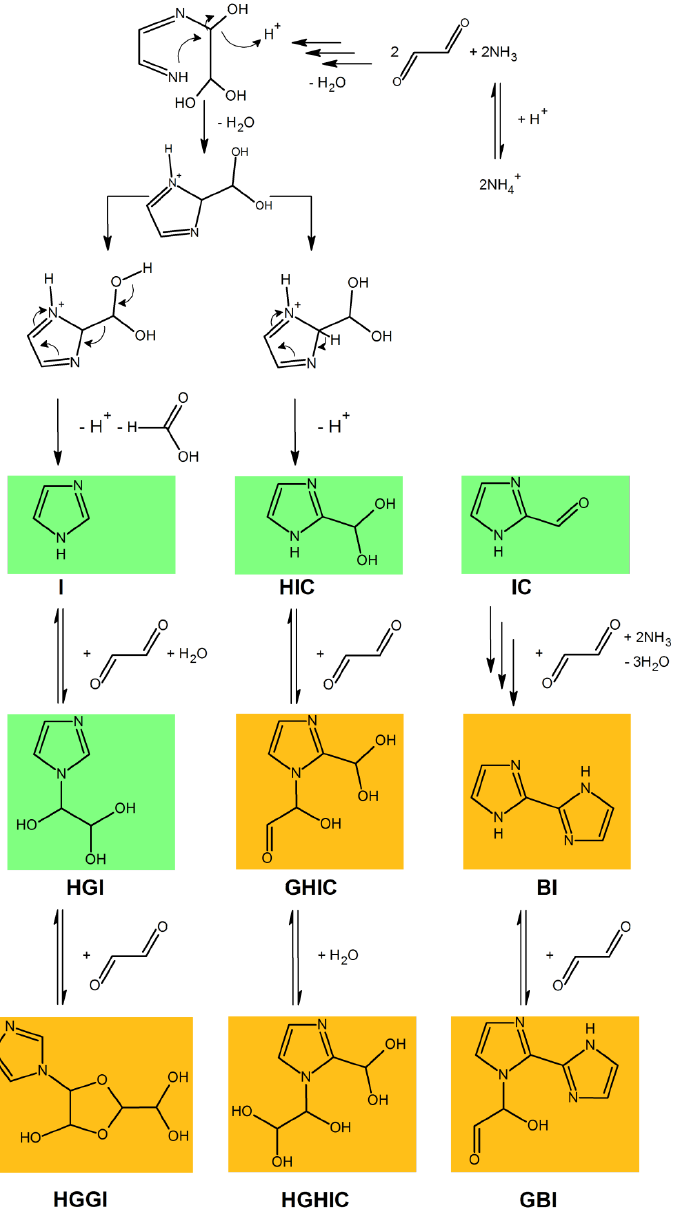
Figure 1. Proposed reaction pathways for imidazole formation in the glyoxal / ammonium sulfate system are shown. Green colored compounds were previously described in literature (Galloway et al., 2009; Yu et al., 2011); orange colored compounds were identified in this work.